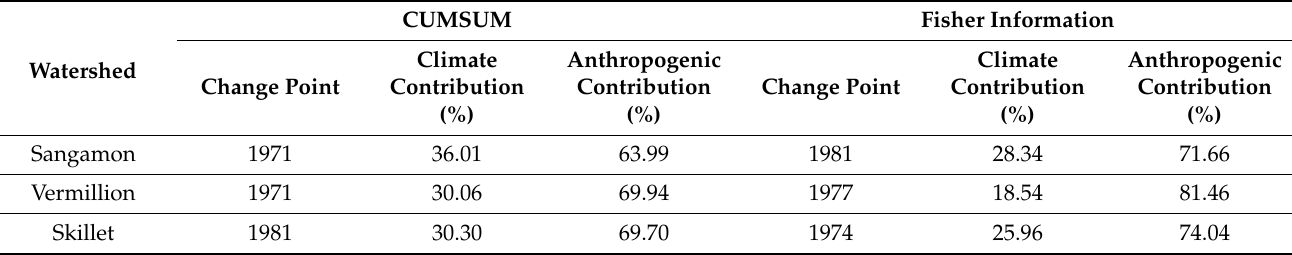
Figure 7. Analyses of regime shifts of annual streamflows and precipitation time series using Fisher Information for ( a ) the Sangamon watershed; ( b ) the Vermillion watershed, and ( c ) the Skillet watershed. The black and red (dashed) vertical lines show the start of transition from one regime to the another and starting of new regime (year of regime shift), respectively. Table 3. Percentage contribution from humans and the climate towards streamflow changes, according to both CUMSUM and FI methods for the Sangamon, Vermillion and Skillet